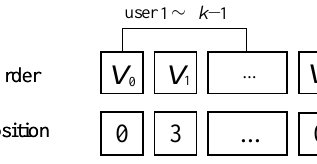
Figure 4. Coding scheme in the genetic